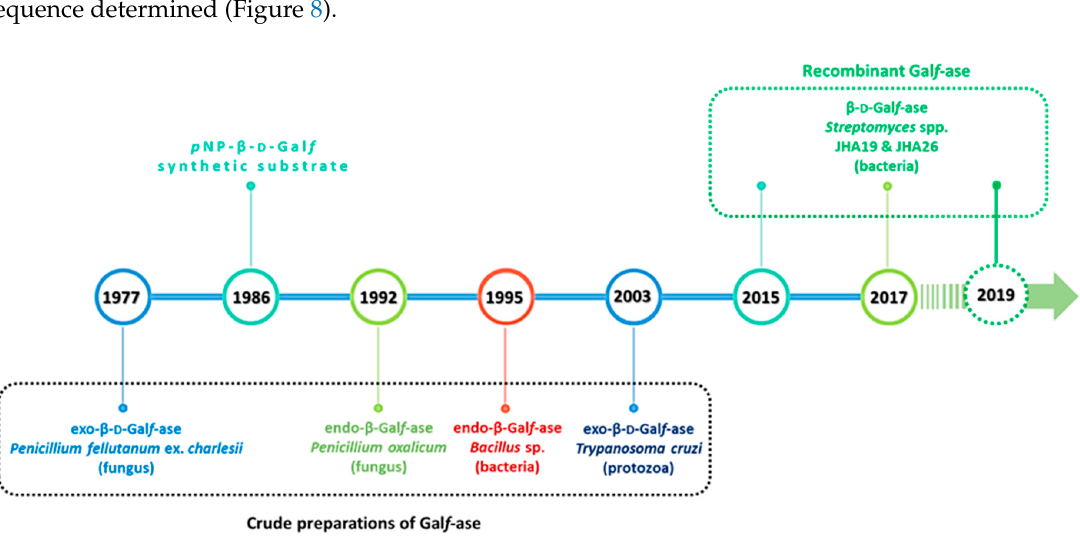
Figure 8. Schematic representation of the timeline of Gal f -ase discoveries and studies over the past forty years.